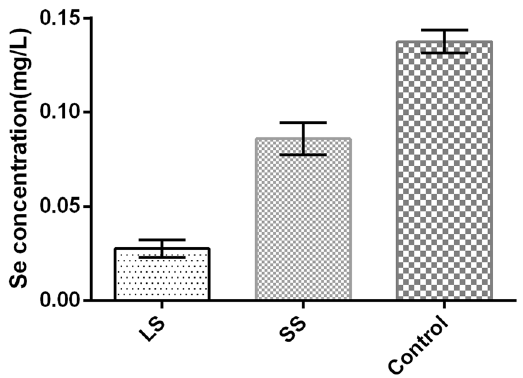
Figure 2. Se concentration for each group. Se concentrations in the blood of rats were analyzed by spectrophotometry. * P < 0.05 vs. control; # P < 0.05 vs. LS. LS, low selenium; SS, selenium